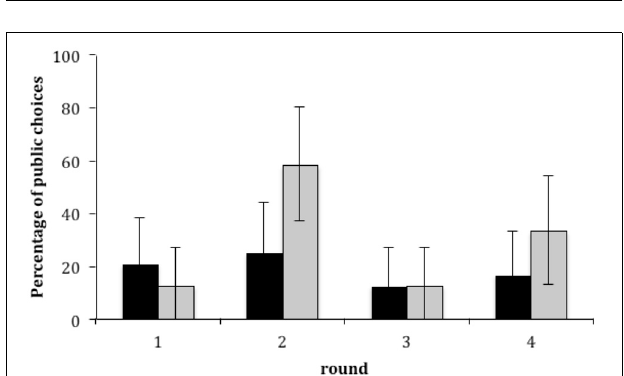
FIGURE 3 | Percentage of choices of public outcome for the four rounds of the game for boys (black bars) and girls (gray bars) shown as mean ± 95%